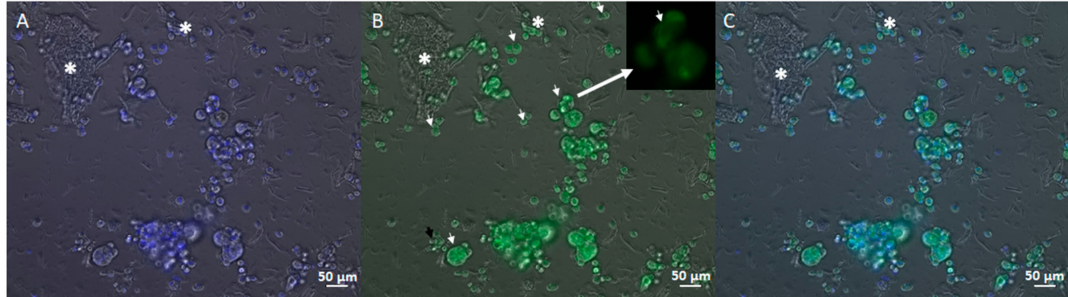
Figure 8. Inverted microscopy images of the cell MDA-MB231 cultured in the 3D sca ff old at 7 days (20 × magnification). ( A ) Hoechst 33,342 labelled cells; ( B ) Acridine Orange labelled cells; ( C ) superimposition of ( A , B ) images. Acridine Orange stains viable cells and labels the DNA in the nucleus in light green. The white stars represent the matrix deposed by the cells. In panel ( B ), is visible a cell in division (black square in the upper part of the images). In this case, DNA separation is visible.